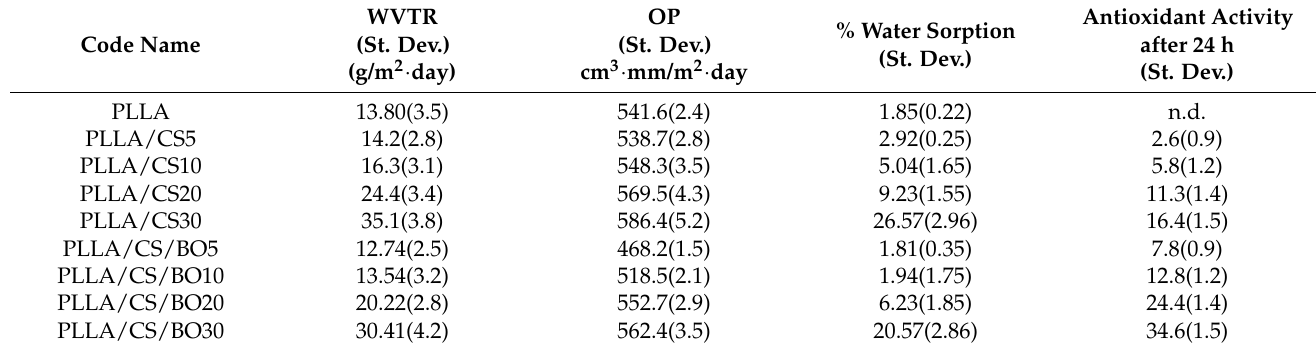
Table 3. Water vapor transmission rate (WVTR), Oxygen Permeability (OP), water sorption, and antioxidant activity values of all tested PLLA/CS and PLLA/CS/BO composite films.